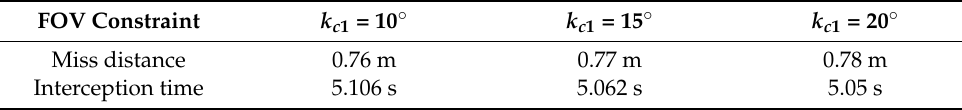
Table 5. Biased parameters.